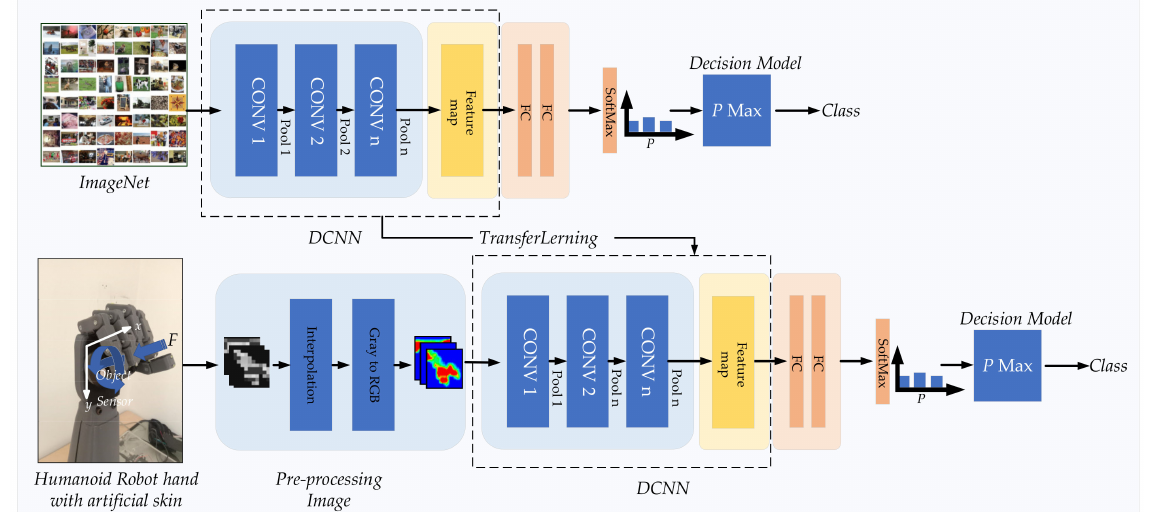
Figure 17. DCNN Transfer Learning method was used in this